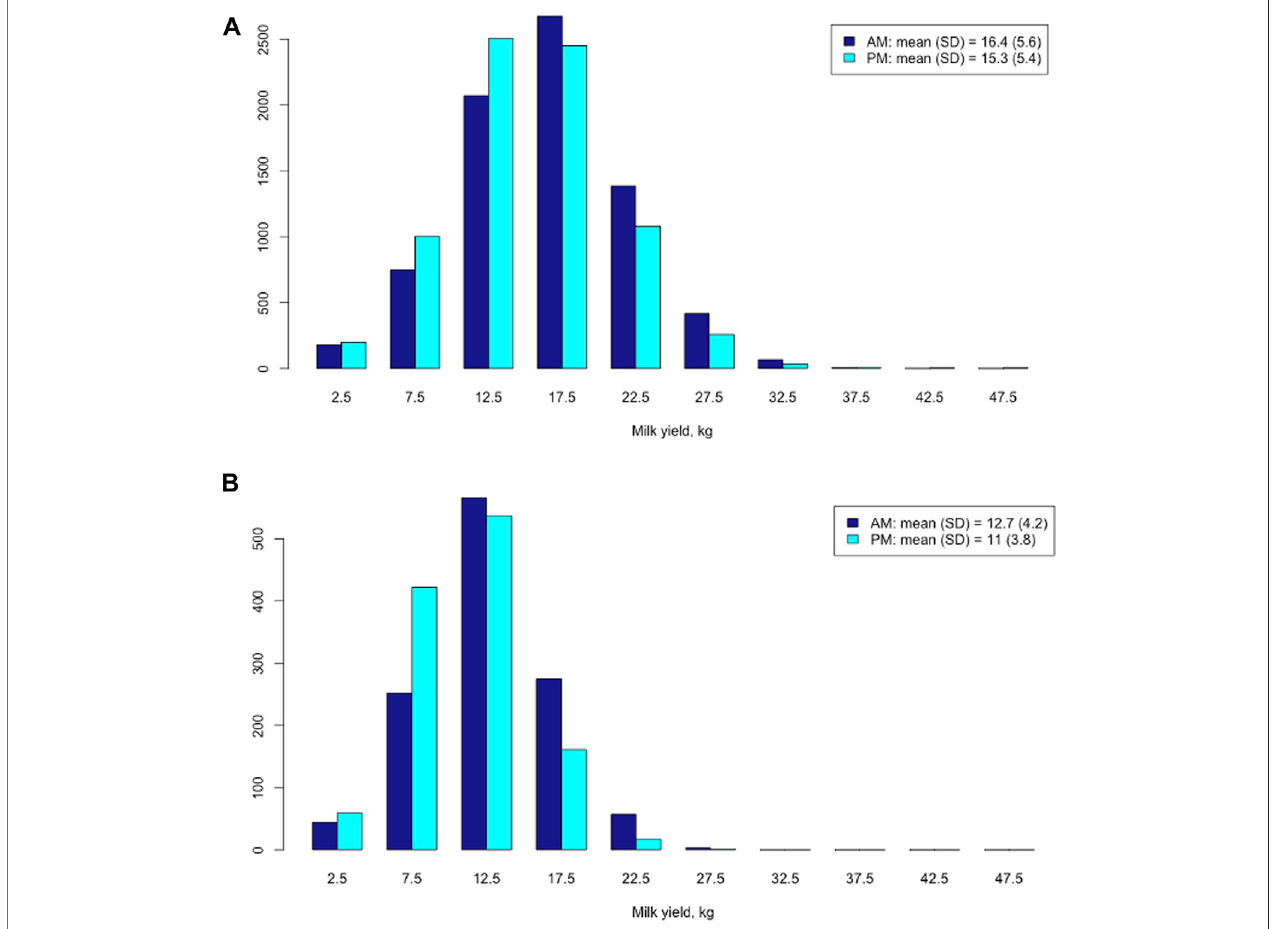
FIGURE 2 | Distribution of morning (AM) and evening (PM) milk yields in Holstein cows (A) and Jersey cows (B) , respectively.